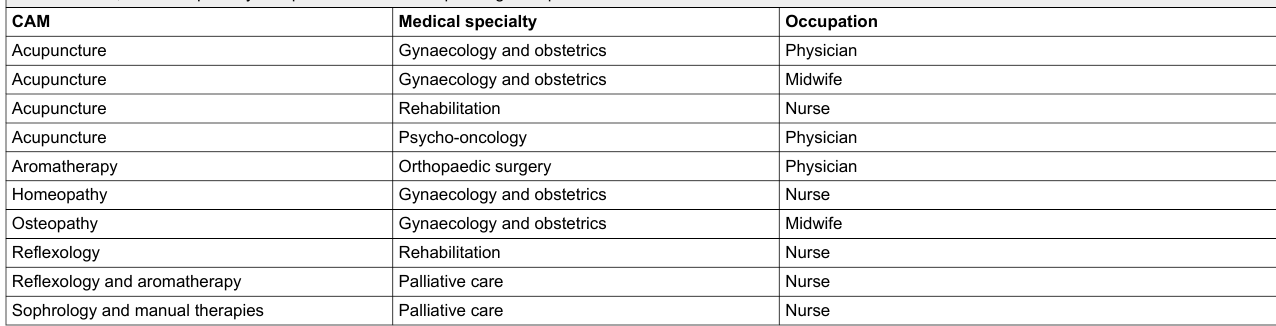
Table 2: CAM, medical specialty and profession of the responding